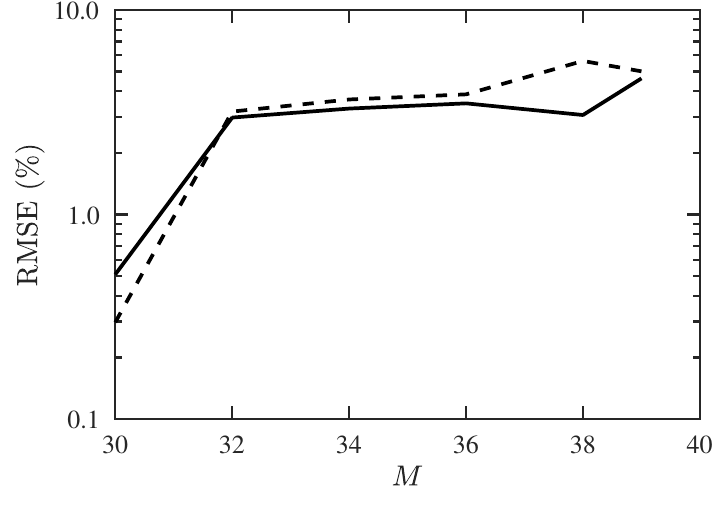
Figure 8. RMSE of DOA and CF estimation with proposed PJE algorithm, under different numbers of signal sources, SNR = 10 dB, Q = 300, M u = 10. ———: RMSE of DOA, − − − : RMSE of